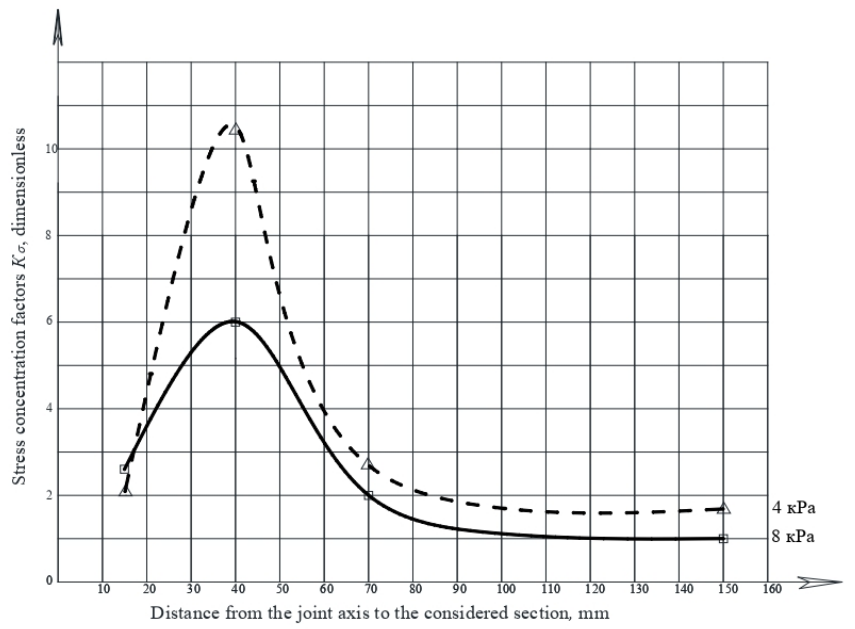
Figure 9. The hoop stress concentration in the field joint zone of the wall with a bend of 50 mm in section C-3.